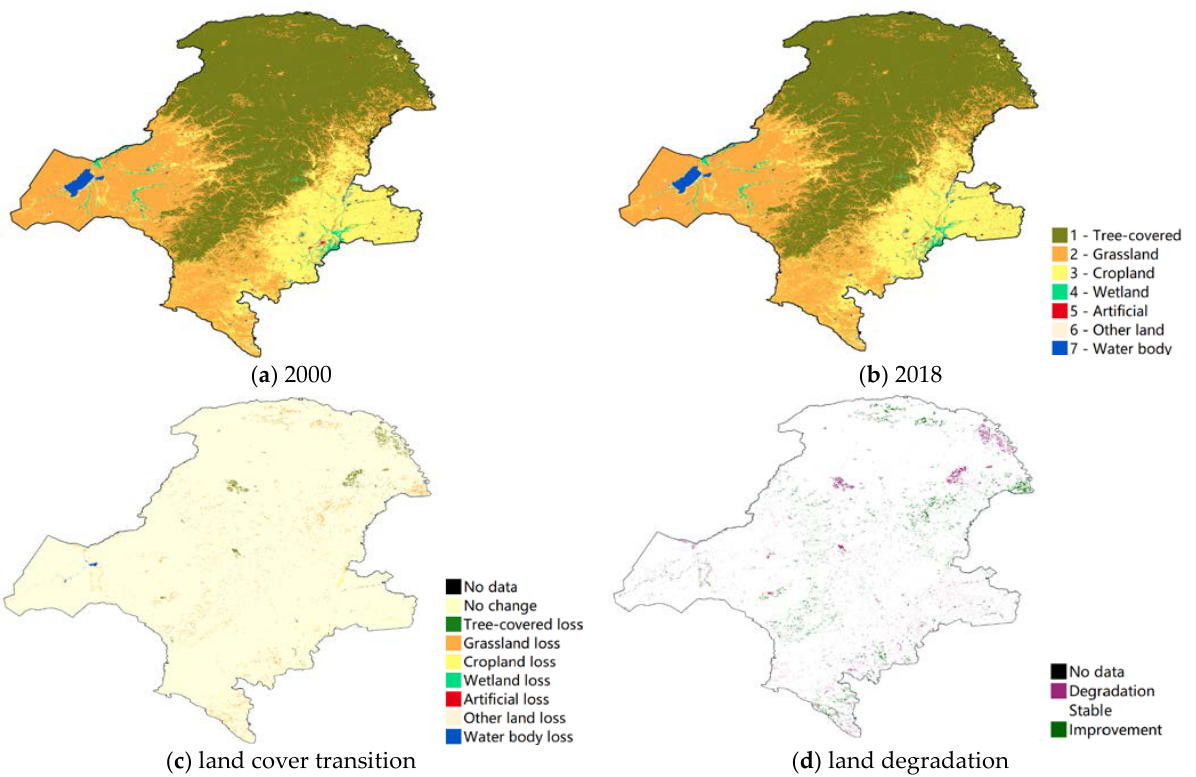
Figure 4. Land cover change and degradation in Great Khingan Mountain (GKM), China